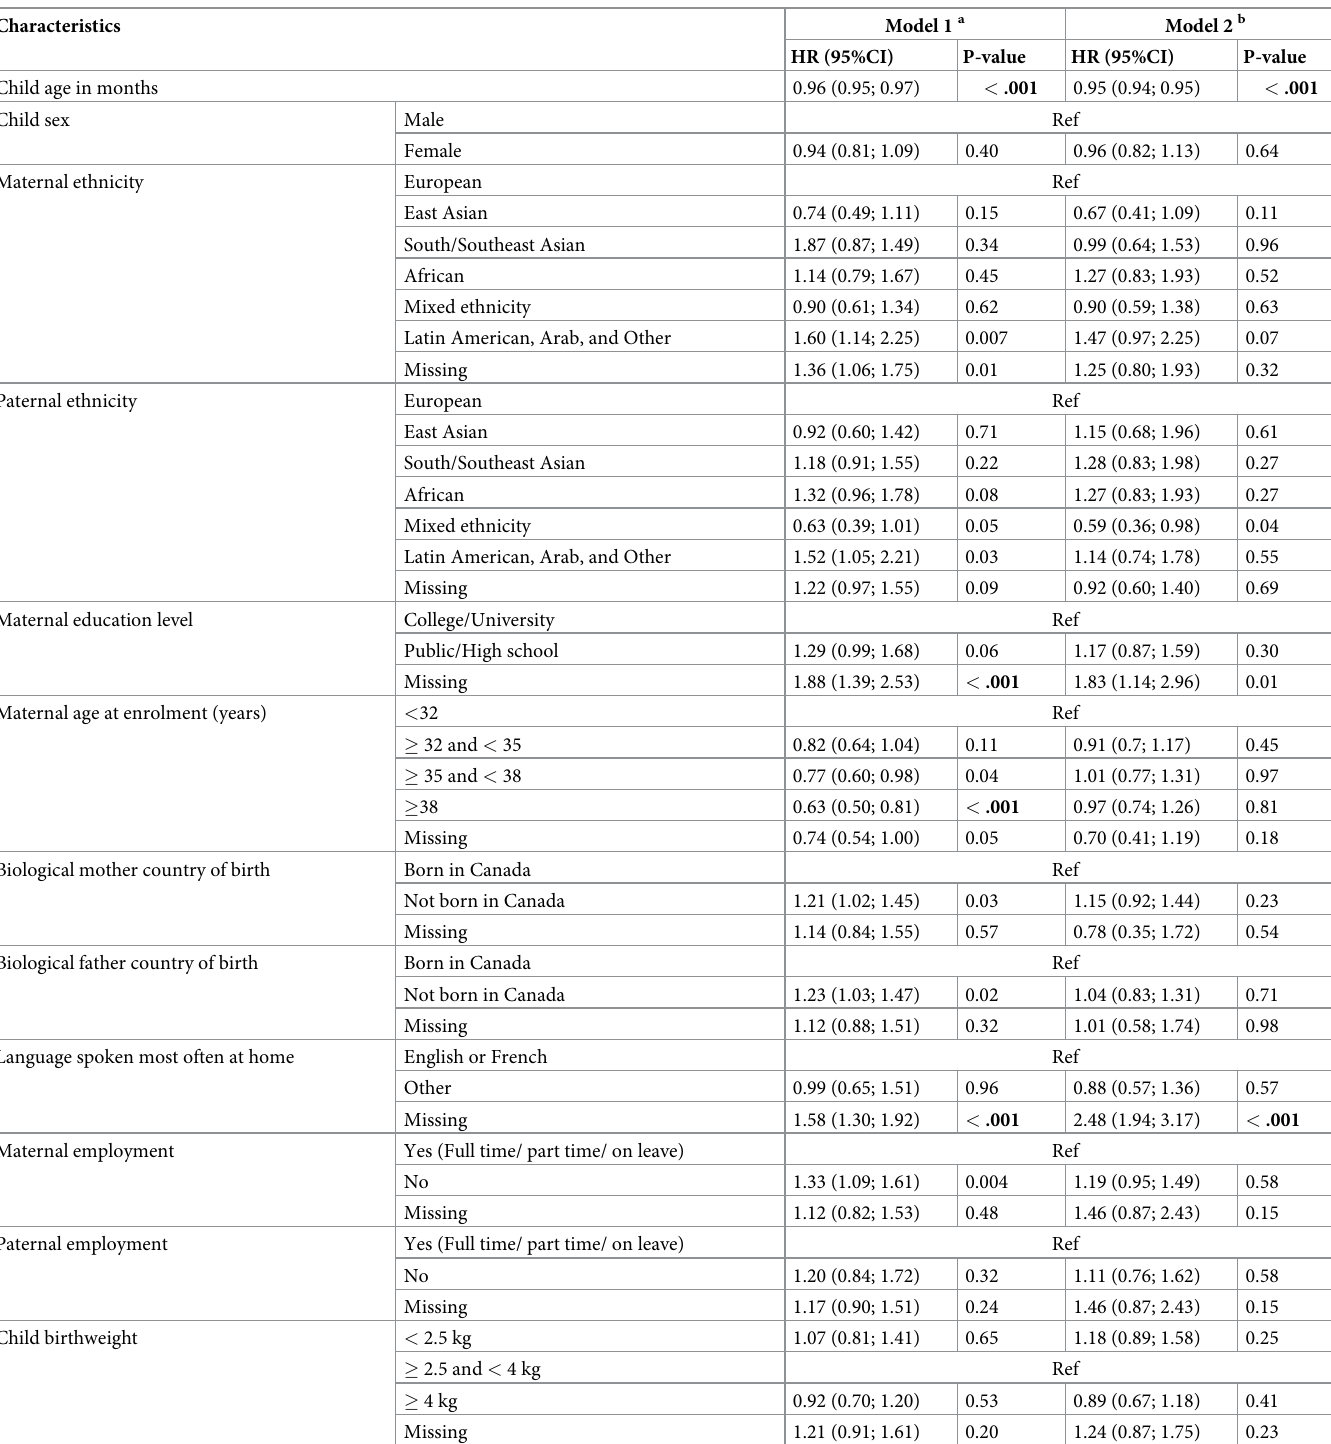
Table 5. Factors associated with time to withdrawal (10,914 subjects).